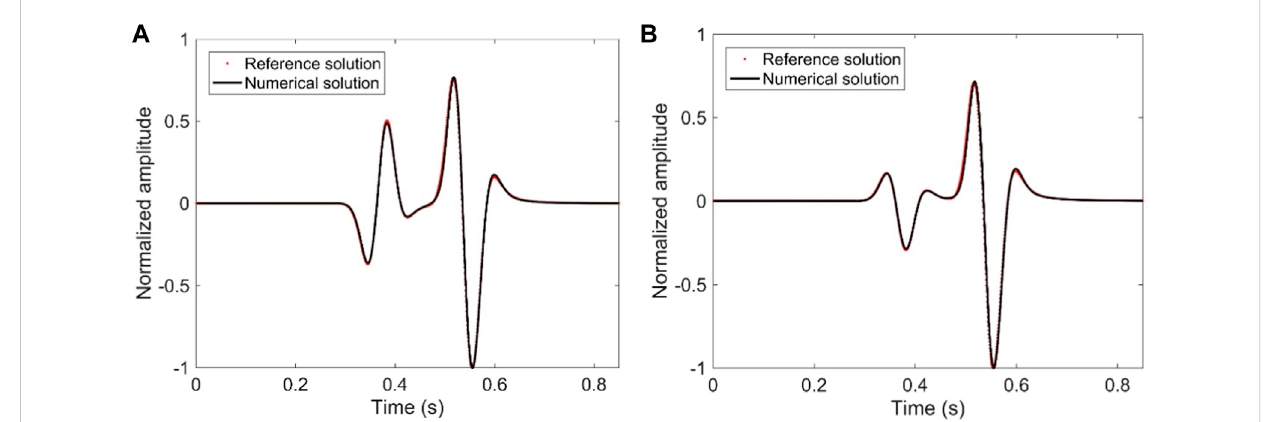
FIGURE 7 Normalized waveform records computed by the MSDG method within the time interval of [0 s, 0.8 s] in homogeneous medium. (A) u 1 and (B) u 2 .